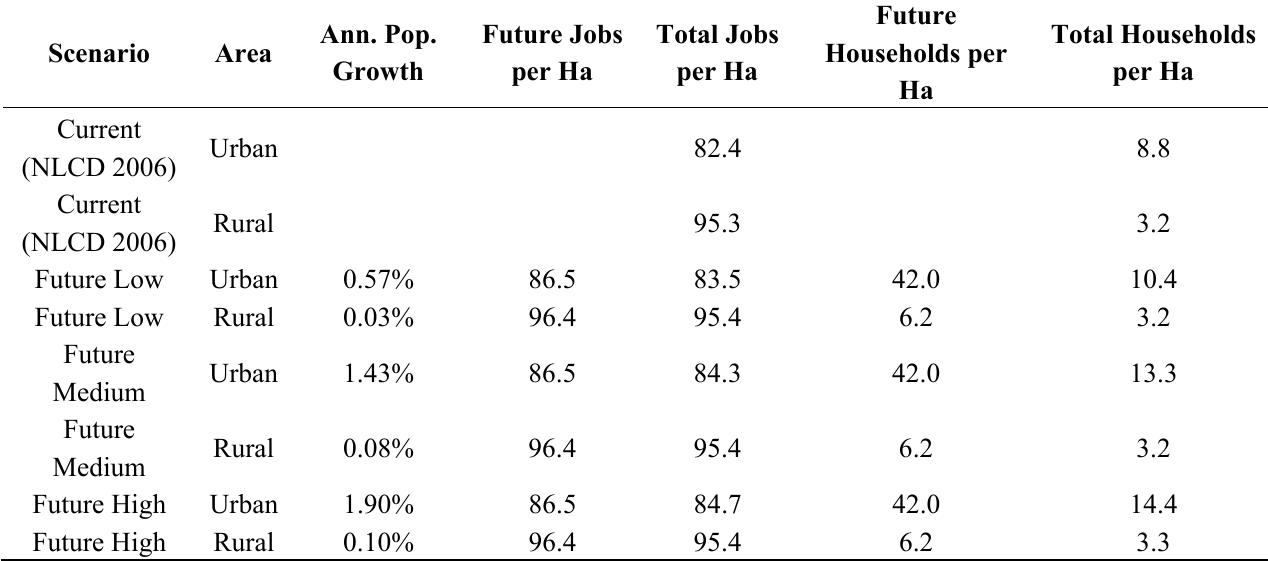
Table 4. Summary of the metrics used to calculate area of new urban land cover by the year 2050.